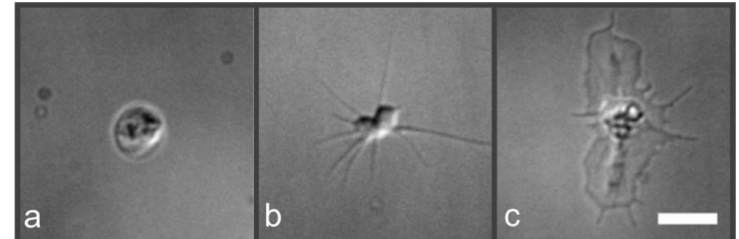
Figure 1. DIC images of human platelets at three different morphological states upon platelet shape change (cell culture medium on plain glass support). Upon glass contact, platelets adopt a round shape ( a ) that facilitates cell adhesion. Subsequently, filopodia form a spindle-like morphology ( b ). Lamellipodia fill the area between individual filopodia, and platelets spread further forming a so-called “fried-egg” morphology ( c ) [1,16]. Scale bar 5 µ